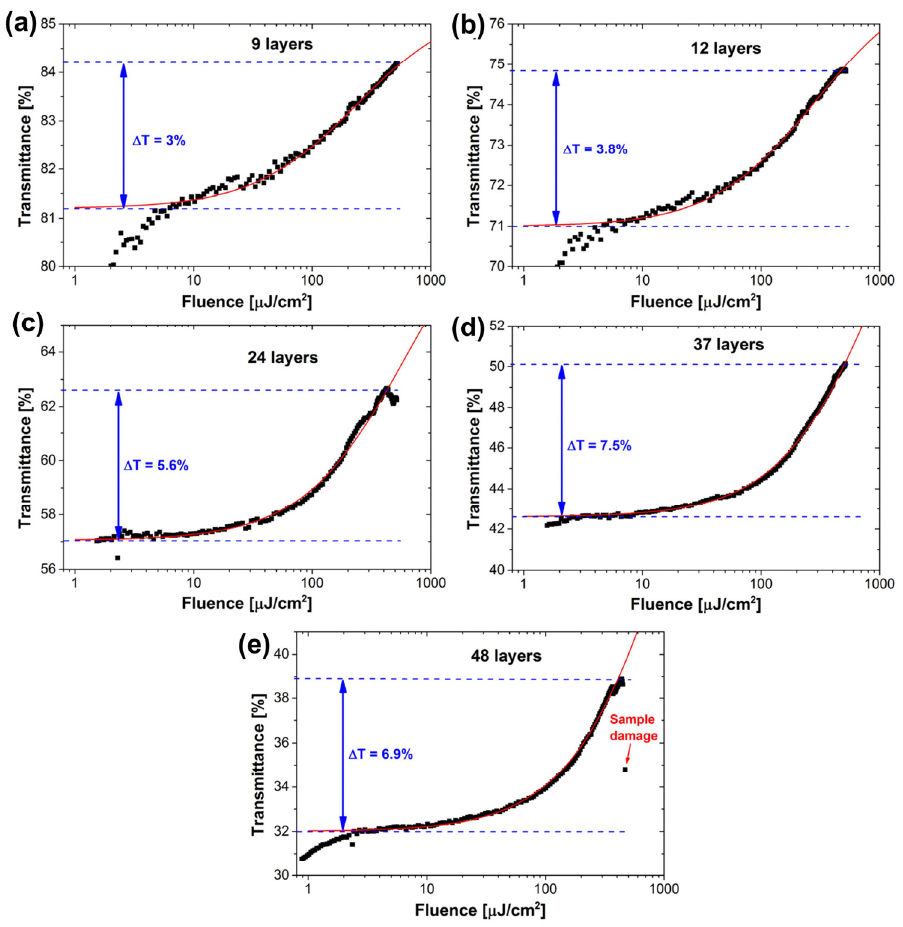
Figure 6. Measured power-dependent transmission of the fabricated multilayer graphene SAs: ( a ) 9 layers, ( b ) 12 layers, ( c ) 24 layers, ( d ) 37 layers, and ( e ) 48 layers. Reproduced from ref. [61]. Optical Society of America, 2015.